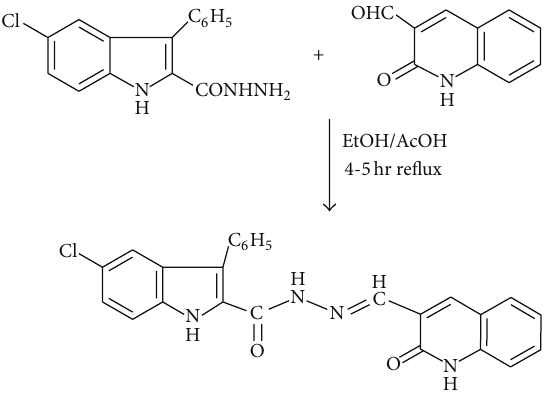
Scheme 1: Synthesis of Schiff base ligand